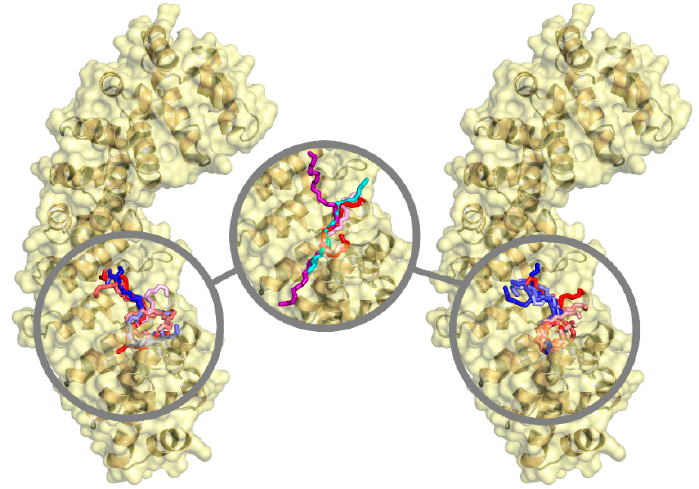
Figure 11. Binding location of seven residue long fragments of the two NLS regions of PADI4 on the surface of Imp α 3 observed in simulations. ( Left ) conformations of peptide NLS1, and ( right ) peptide NLS2 region. Fragments follow the color scheme red → magenta → blue, going from the N to the C terminus of the two NLS peptides. (Center) comparison among the fragments with the most favorable binding affinity of (magenta) NLS1-PADI4 and (red) NLS2-PADI4, and (cyan) crystallographic pose [66] of the NLS of the Ran-binding protein 3 (purple) and the Epstein–Barr virus EBNA-LP protein (cyan) bound to the major binding sites of Imp α 3 and Imp α 1, respectively. For clarity, the sole backbone chain is shown for all the sequences.